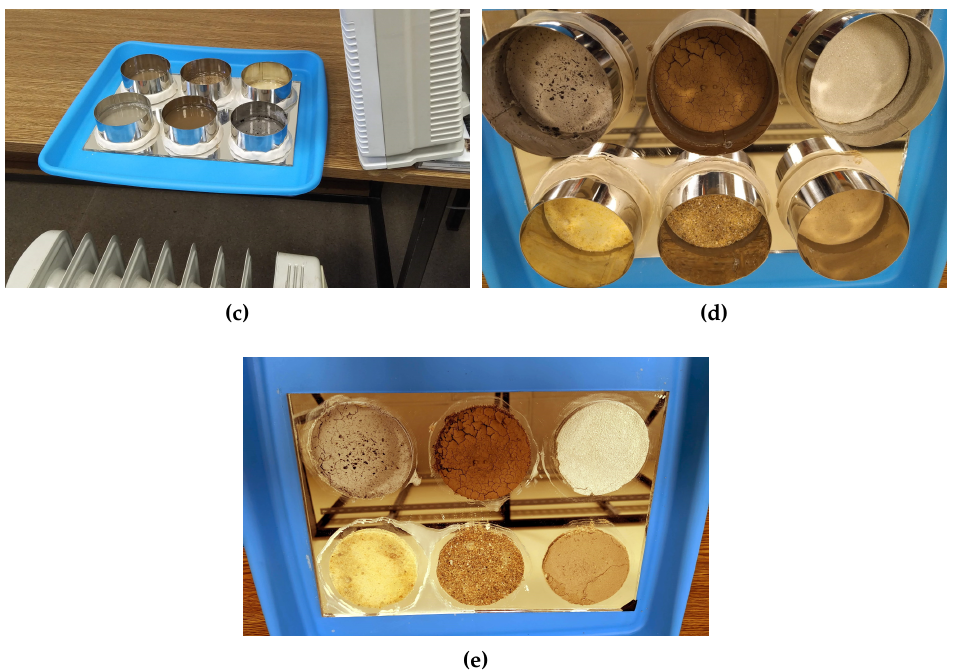
Figure 7. Results of the procedure for the application of 5g of pollutants on the reflectors. ( a ) Cylinders glued to the reflector using elastic clay; ( b ) diluted pollutant poured in the cylinders; ( c ) drying of the diluted pollutant; ( d ) result after the drying procedure; ( e ) result after removing the cylinder.